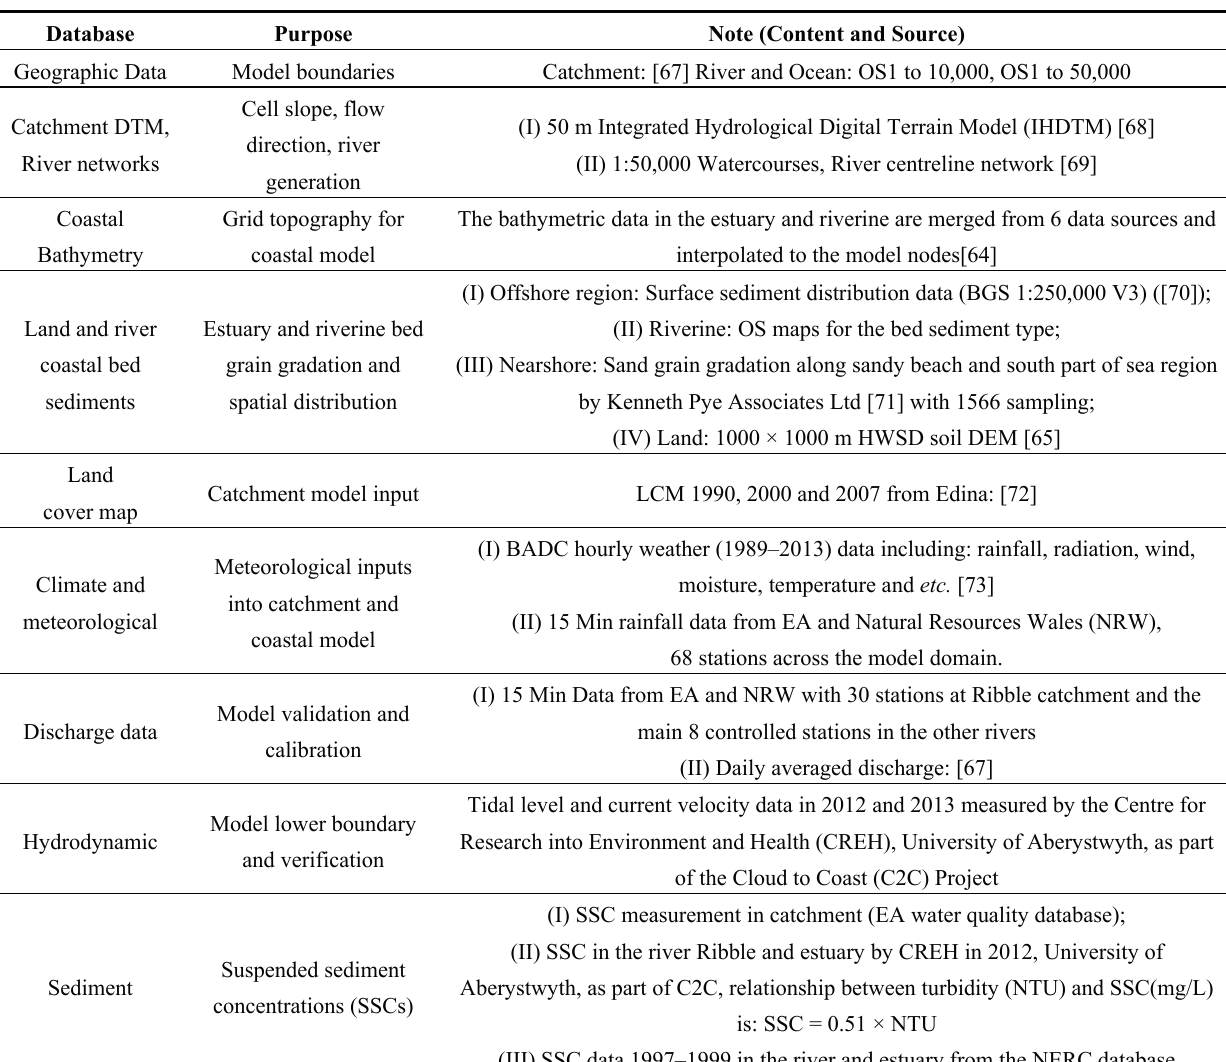
Table 1. Data sources used in the model